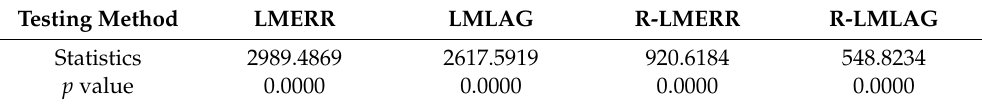
Table 4. LM statistics test results of the housing rent space weight model.